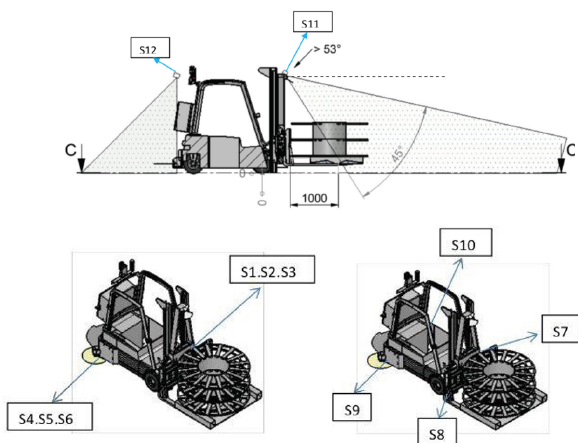
Figure 4. Vehicle and configuration of the twelve sensors mounted on it